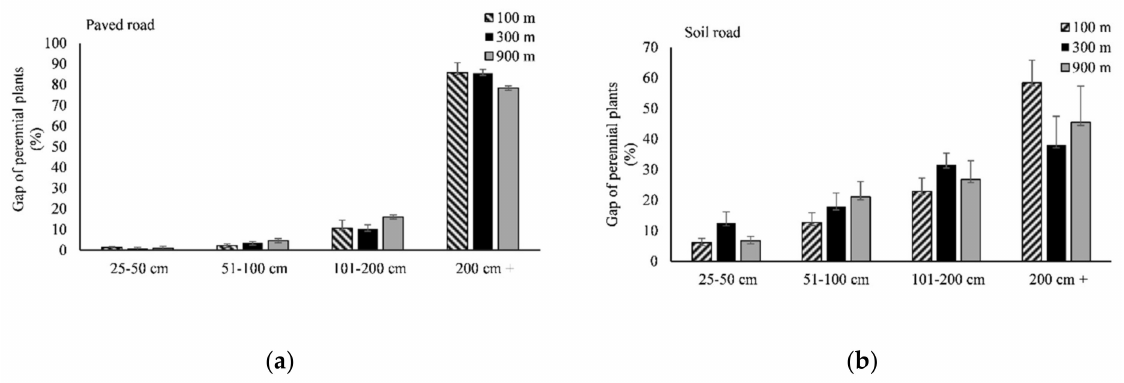
Figure 7. The basal gap between perennial plants at the three distances from the roads. ( a ) The paved roads. ( b ) The dirt roads. Each bar represents mean ±